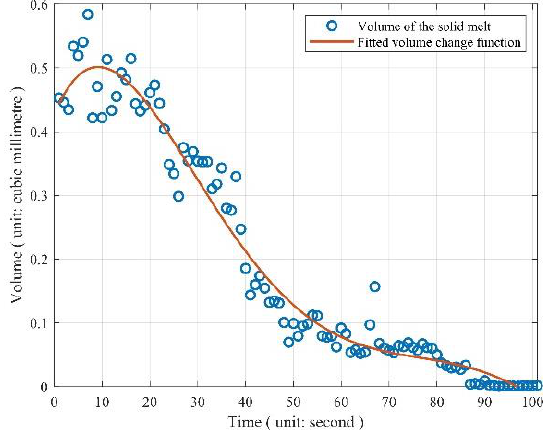
Figure 12. Trend of silicon dioxide melting rate with time.